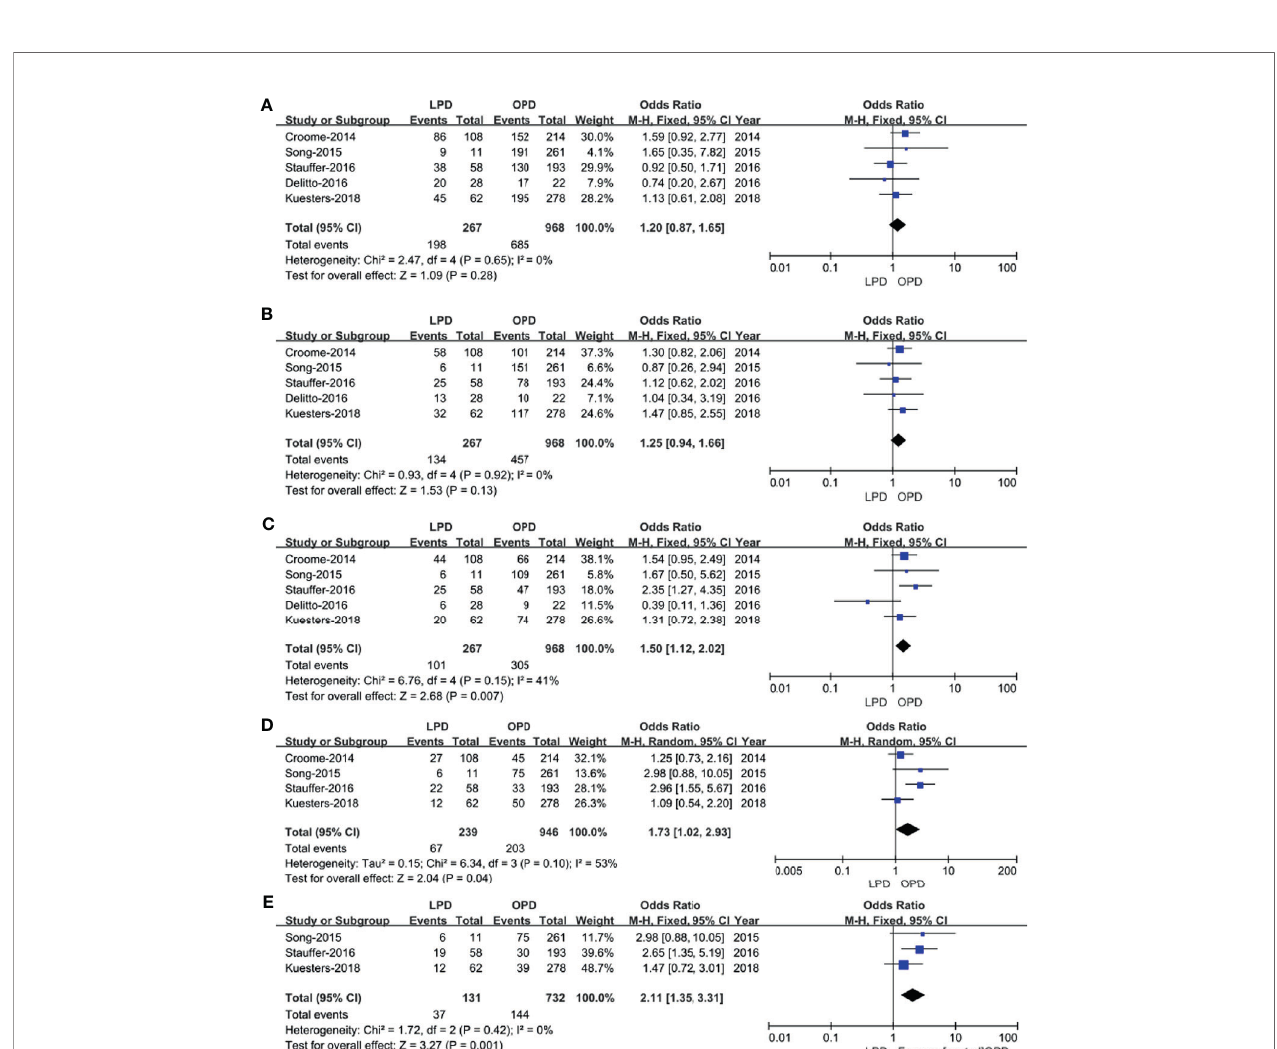
FIGURE 7 | Forest plot of the comparison of LPD versus OPD for long − term oncological outcomes. (A) Forest plot for 1-year survival time; (B) forest plot for 2-year survival time; (C) forest plot 3-year survival time; (D) forest plot for 4-year survival time; (E) forest plot for 5-year survival